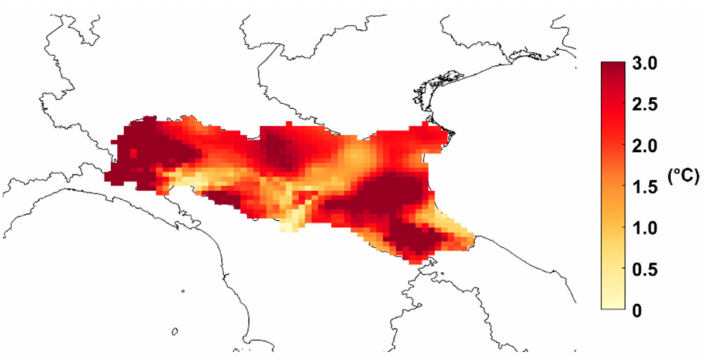
Figure 14. Factors of change for T max,k for the time window 1981–2020 in comparison with the reference time interval 1961–2000.